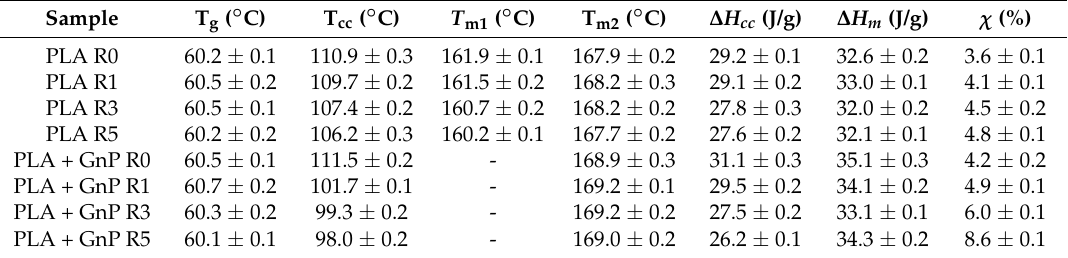
Table 2. Differential scanning calorimeter (DSC) results of PLA and PLA + GnP at different reprocessing